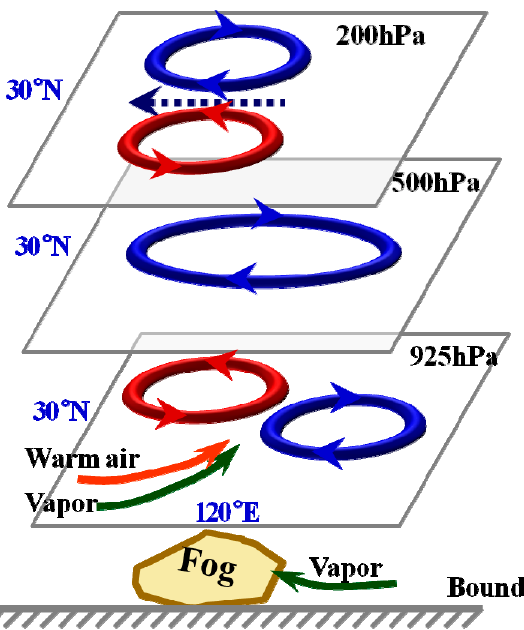
Figure 10. Schematic diagram of the anomalous atmospheric circulations during the extremely persistent dense fog events over Eastern China in the late autumn of 2018. persistent dense fog events over Eastern China in the late autumn of